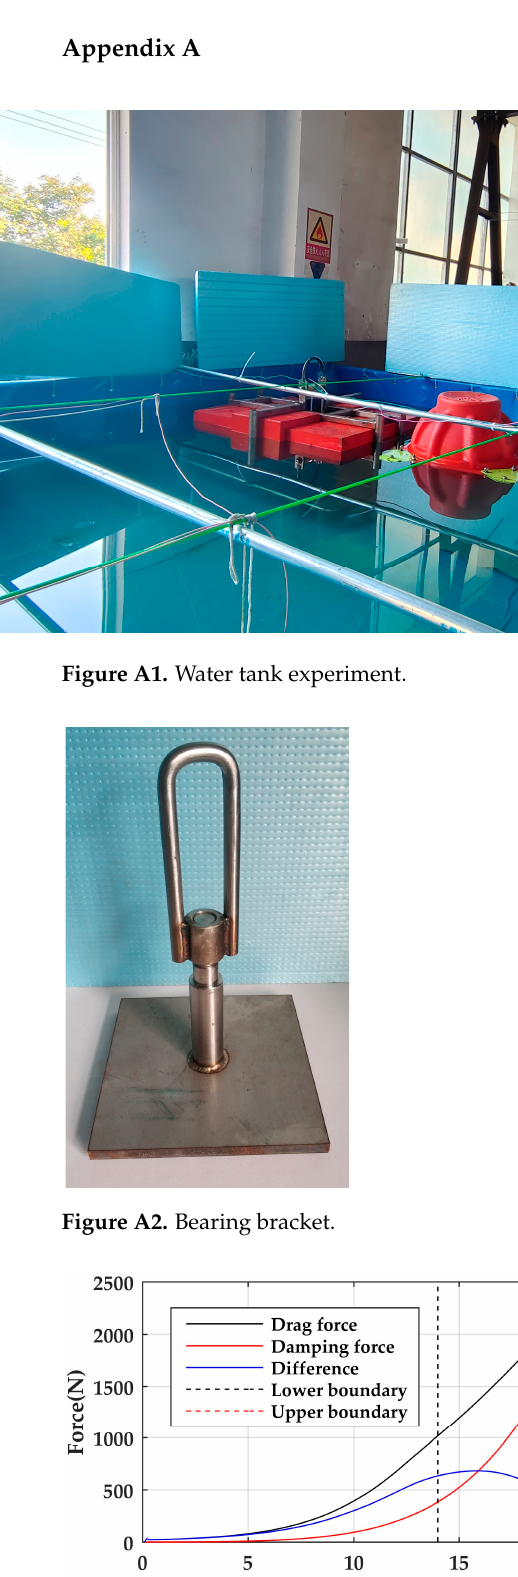
Figure A3. Difference force in group 1.